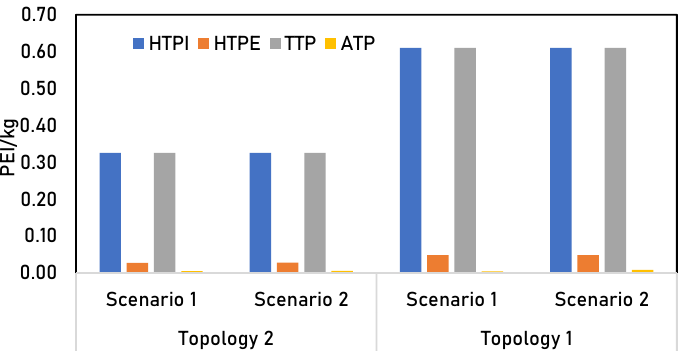
Figure 17. Output rates of PEI for toxicological categories.